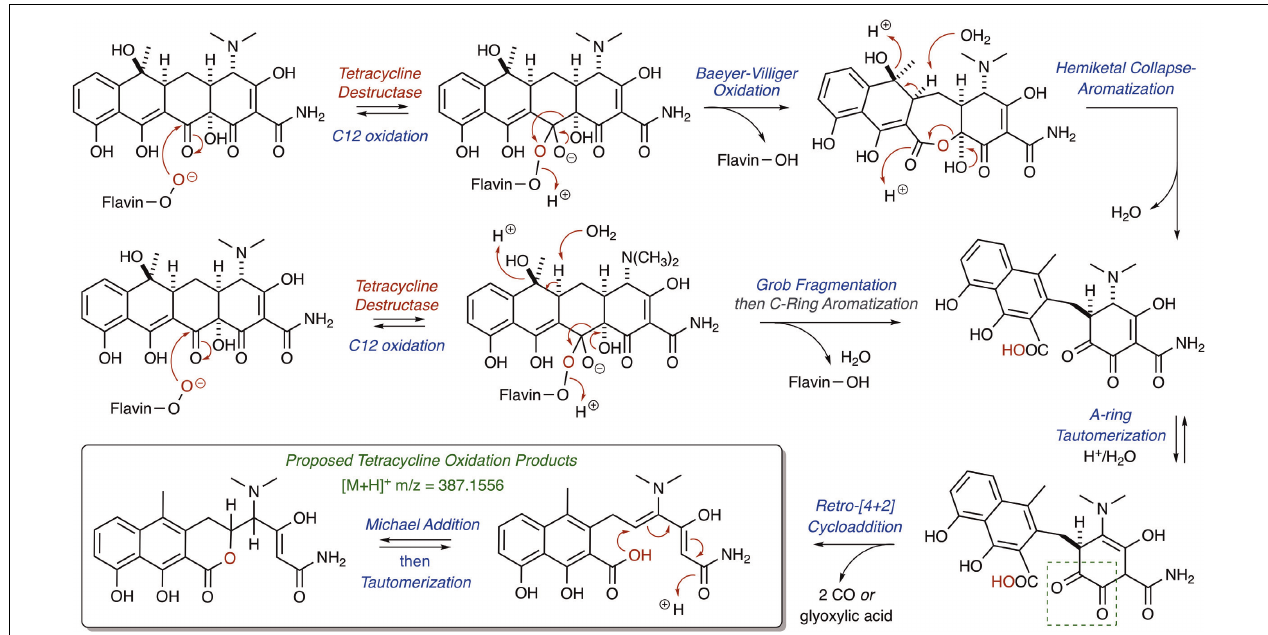
FIGURE 8 | Cascade reactions leading to tetracycline degradation products from enzymatic C12-oxidation of mode I D , A -bound tetracycline.